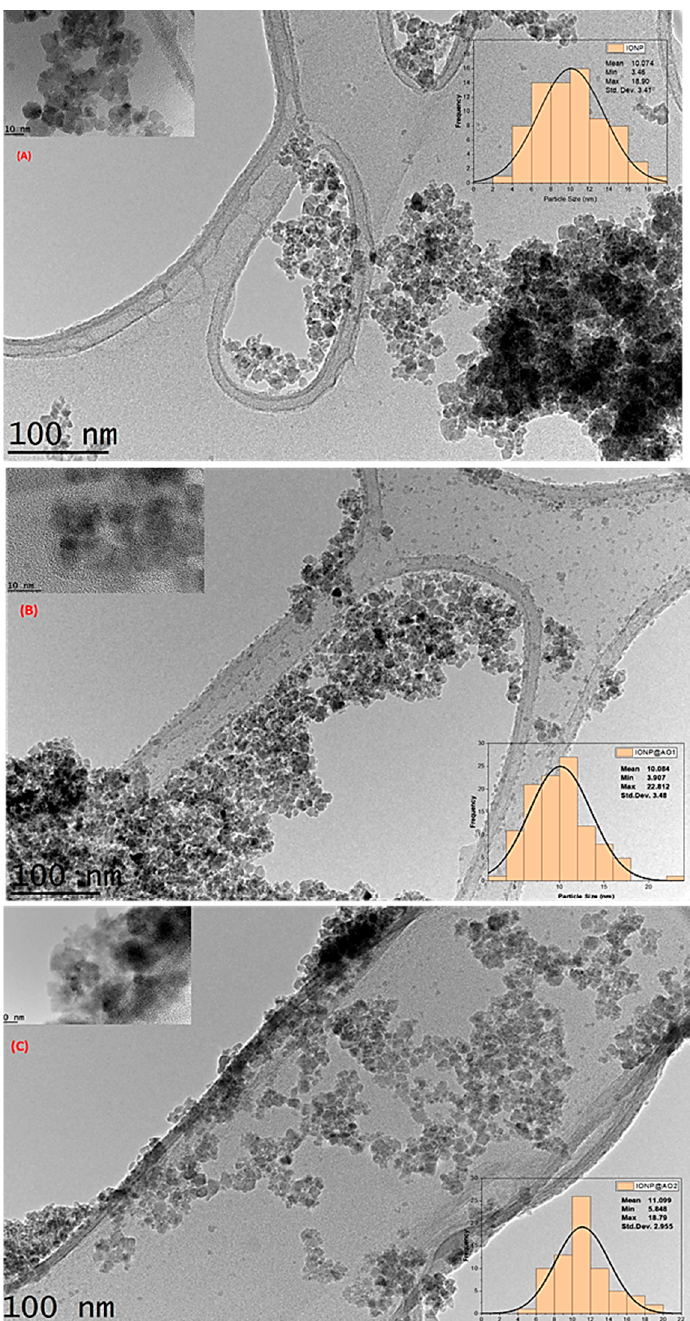
Figure 7. HRTEM images: ( A ) unfunctionalized IONP; ( B ) functionalized IONP@AO1; ( C ) function- alized IONP@AO2. Insets show particle size distribution.